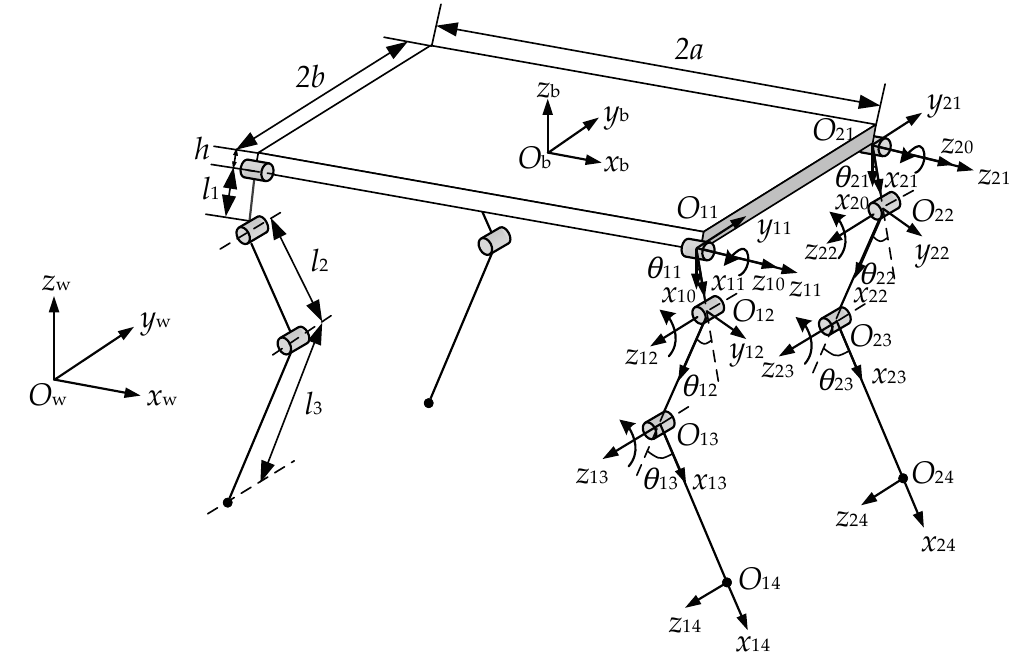
Figure 2. Kinematics model of hydraulic quadruped robot.